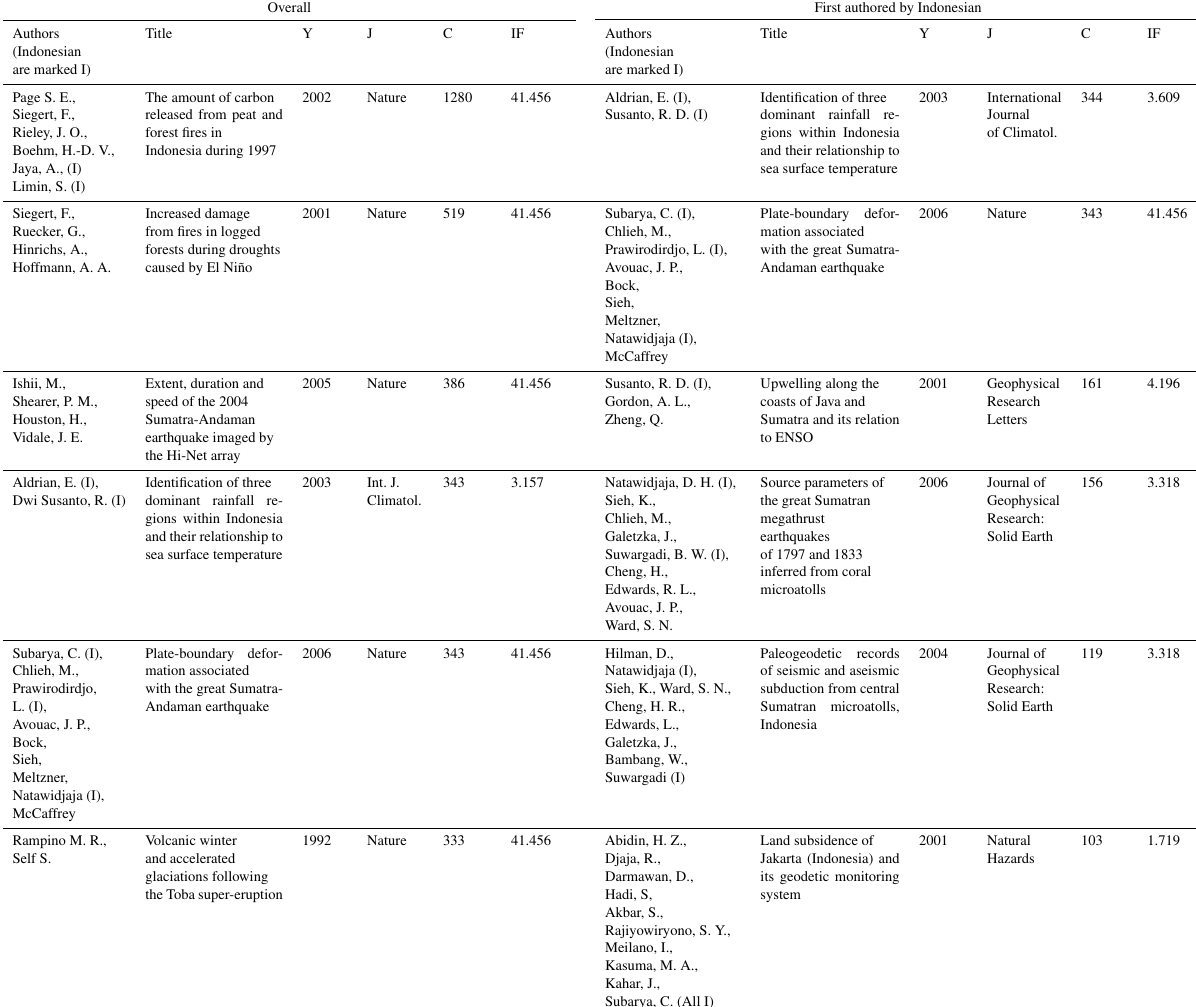
Table 5. Comparing citations authored in general and those first authored by an Indonesian in the 10 most cited papers.